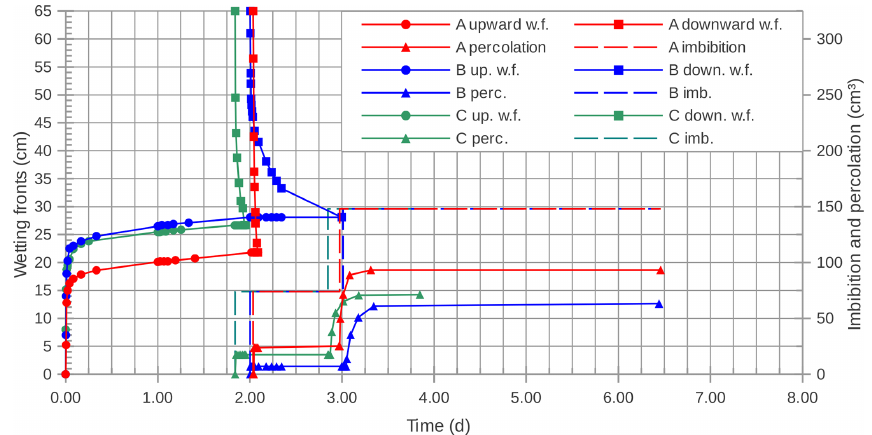
Figure 7. Measures of the position of the water fronts and of the imbibition and percolation volumes collected during the three repetitions of the first experiment. The unitary volume of a vial was estimated to be equal to 74cm 3 for all the soils, according to Barontini et al. (2013). A, B, C: soil identification; (cid:13) : upward moving water front; (cid:3) : downward moving water front; (cid:52) : percolation volume; dashed line: imbibition volume.